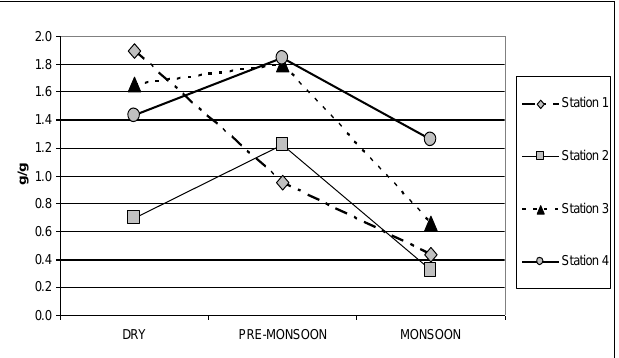
Figure 3: TOM (g/g) at Tok Bali mangrove forest during all seasons 3.2.3 Species Abundance and Composition of Infaunal Bivalves at Tok Bali Mangrove Forest, Kelantan A total of five families with five species were observed at the study area. The families and species of observed infaunal bivalve at Tok Bali mangrove were listed in Table